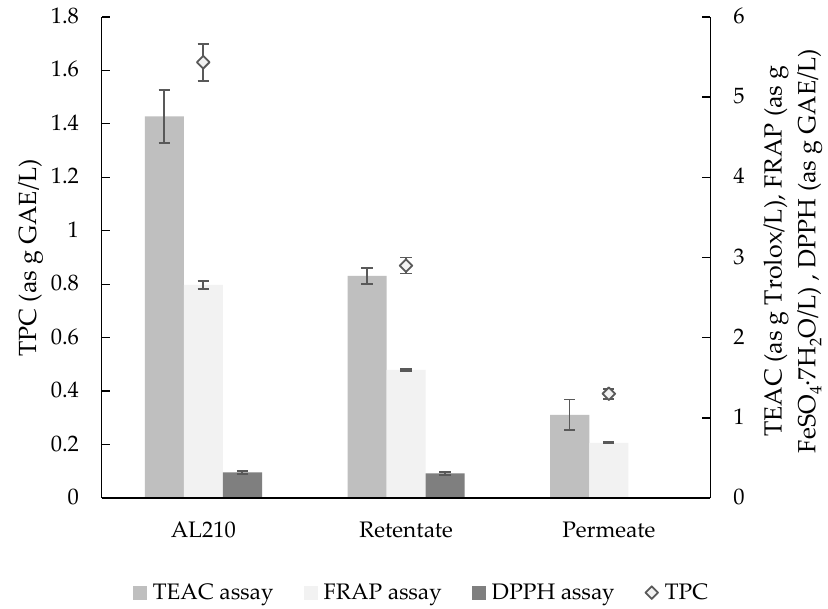
Figure 4. Total phenolic content (TPC) and antioxidant activity determined by TEAC, DPPH, and FRAP assays of AL210, retentate, and permeate. TPC, expressed as g GAE / L; TEAC, as g Trolox / L; FRAP, as g FeSO 4 · 7H 2 O / L; DPPH (EC 50 ), as g GAE / L.